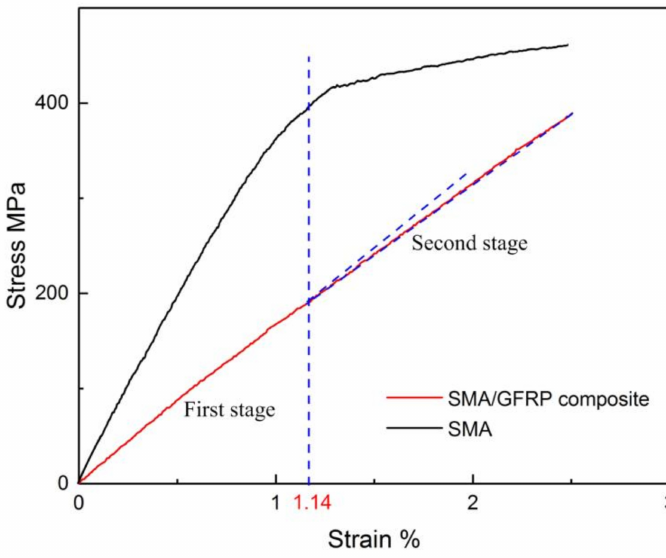
Figure 8. Stress–strain curves of SMA wire and SMA/plain-woven GFRP composite